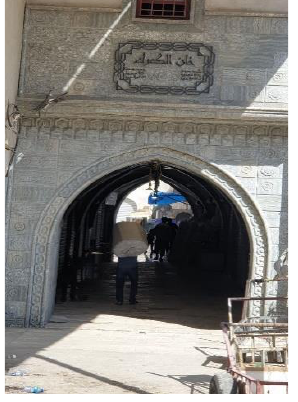
Figure 14. Pictures showing Khan al-Kummark after rehabilitation operations (photo credit: Safaaaldeen ali).